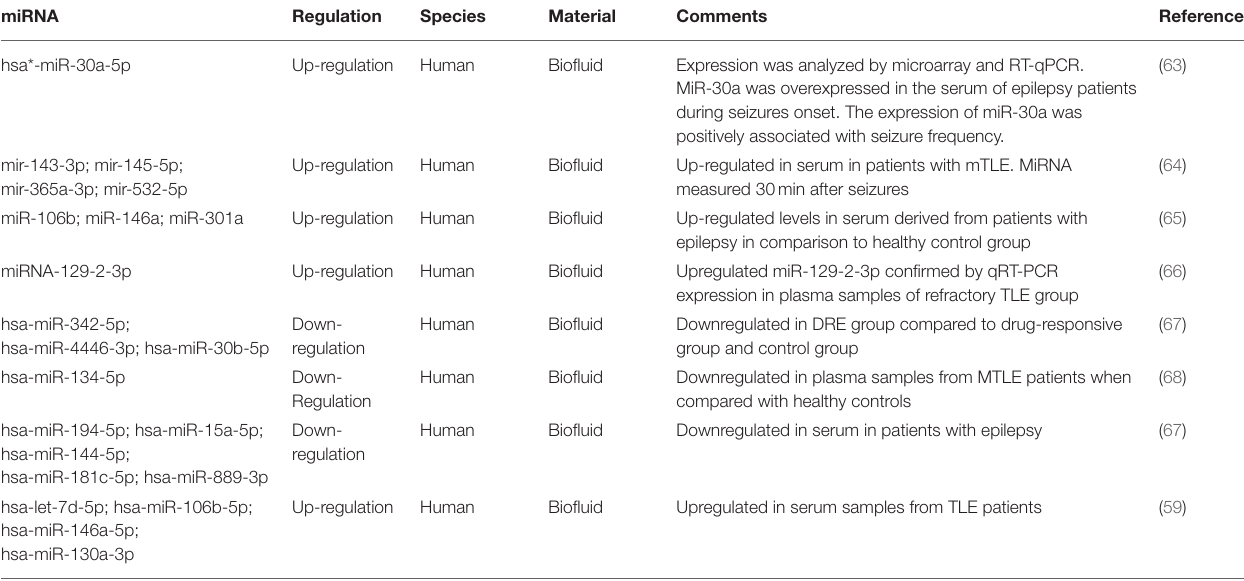
TABLE 1 | Reports on miRNA detected in biofluids from patients with